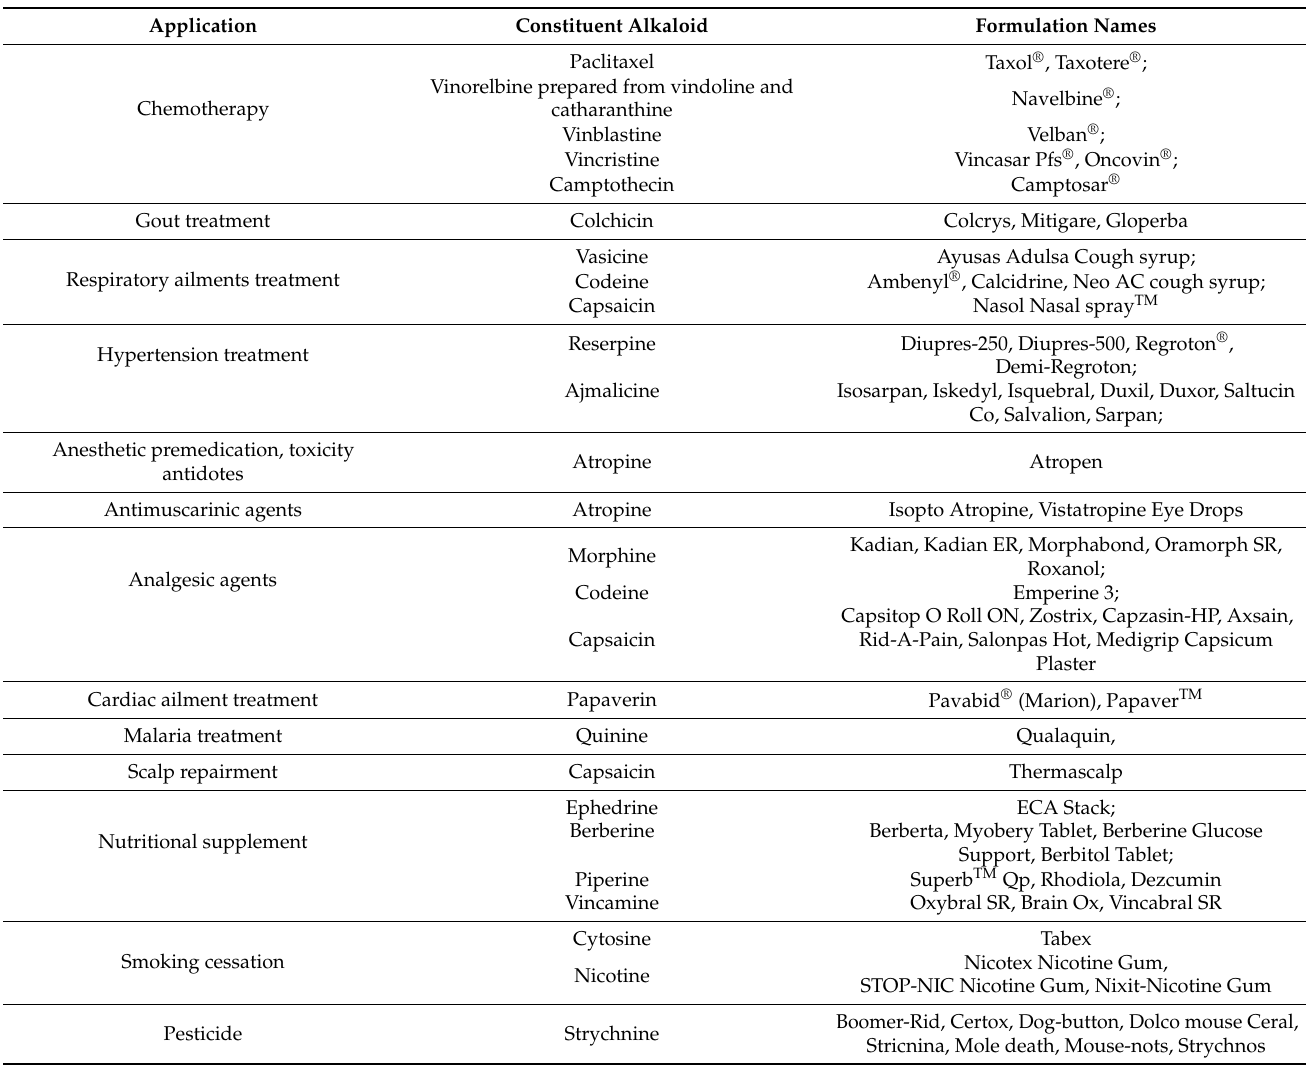
Table 3. Commercial applications of plant alkaloids. Approved formulations of alkaloids and their potential applications have been listed. Information about the formulations has been retrieved from web